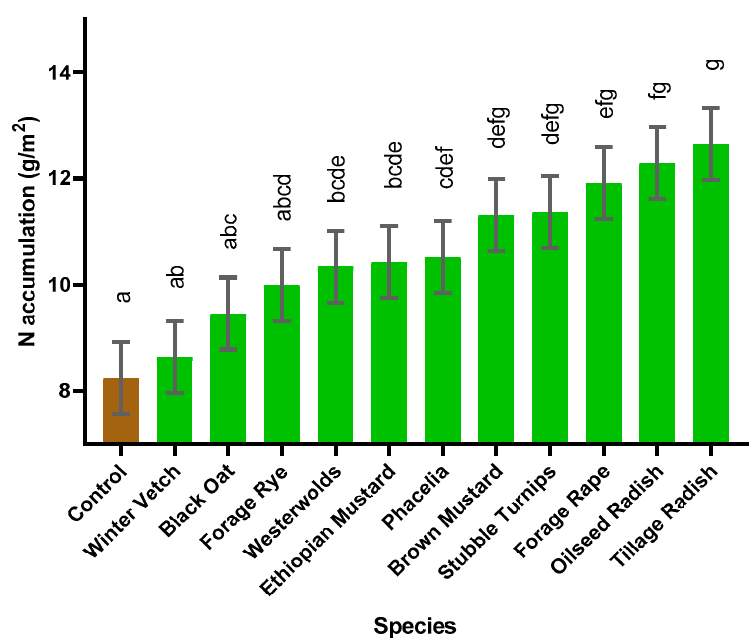
Figure 4. Spring barley total N accumulation as affected by cover crop species (g/m 2 ).The bars represent species mean (N = 6). Error bars represent the Standard Error (SE). Letters represent significant differences between cover crops using Fisher’s post-hoc test 0.05 LSD = 1.874. Means that do not share the same letters are significantly ( p < 0.05) different.